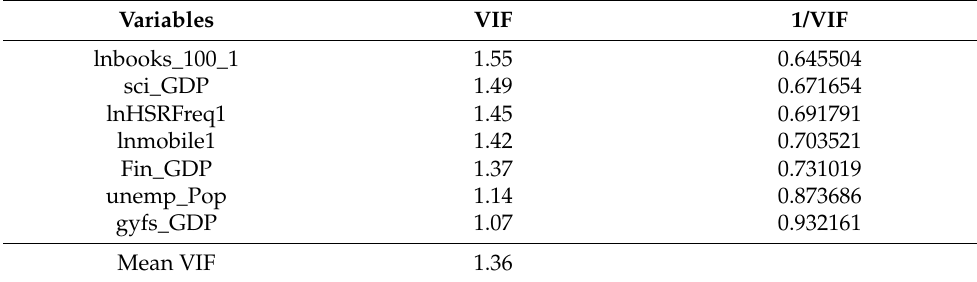
Table 2. Multicollinearity